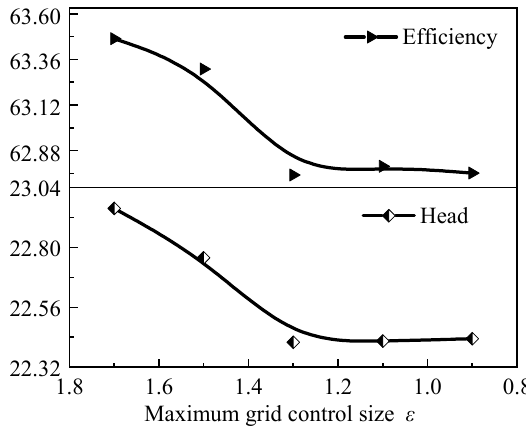
Figure 3. Grid independence analysis.